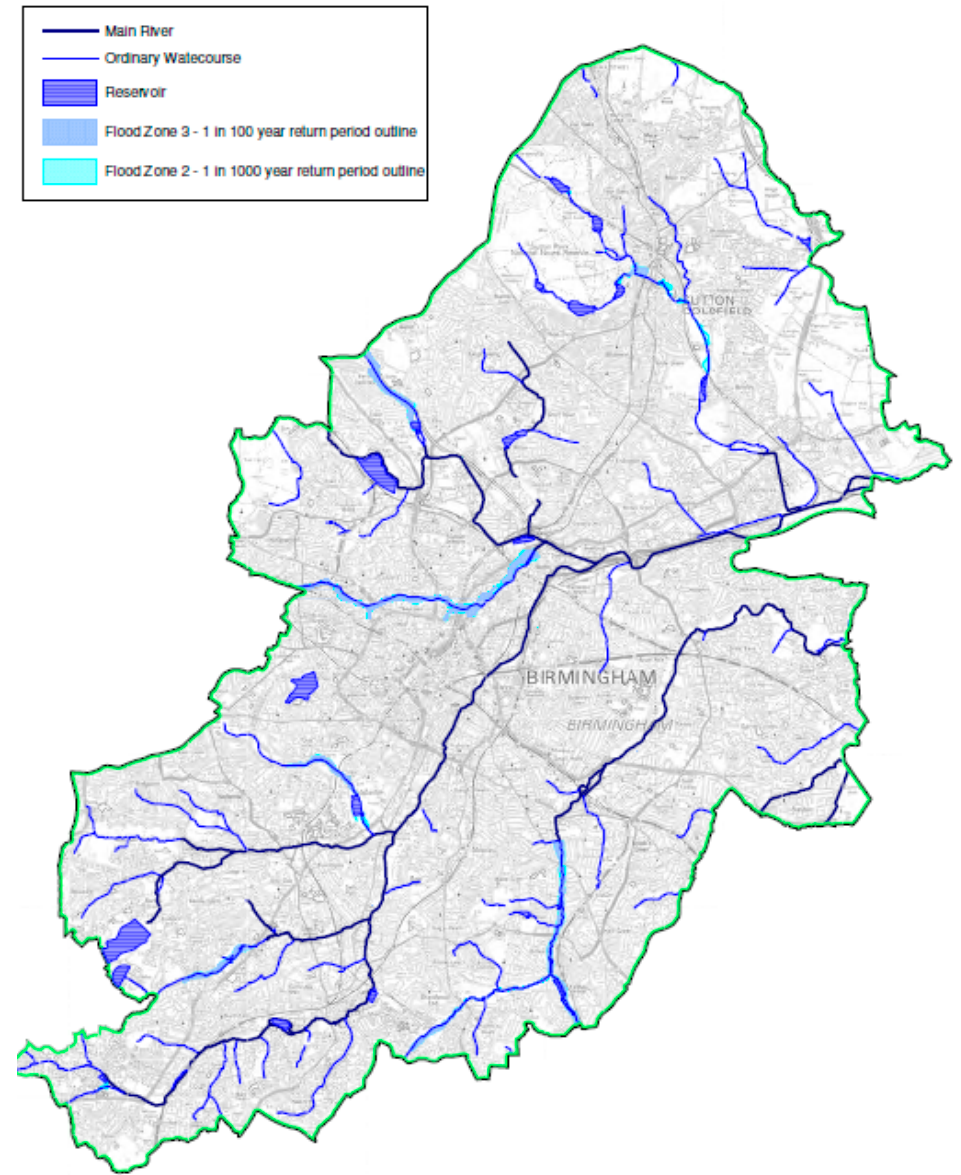
Figure 2. Flood map for ordinary water courses in Birmingham city [33].